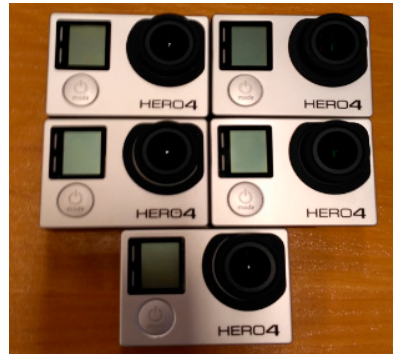
Figure 2. Five cameras GoPro 4 Hero Black.